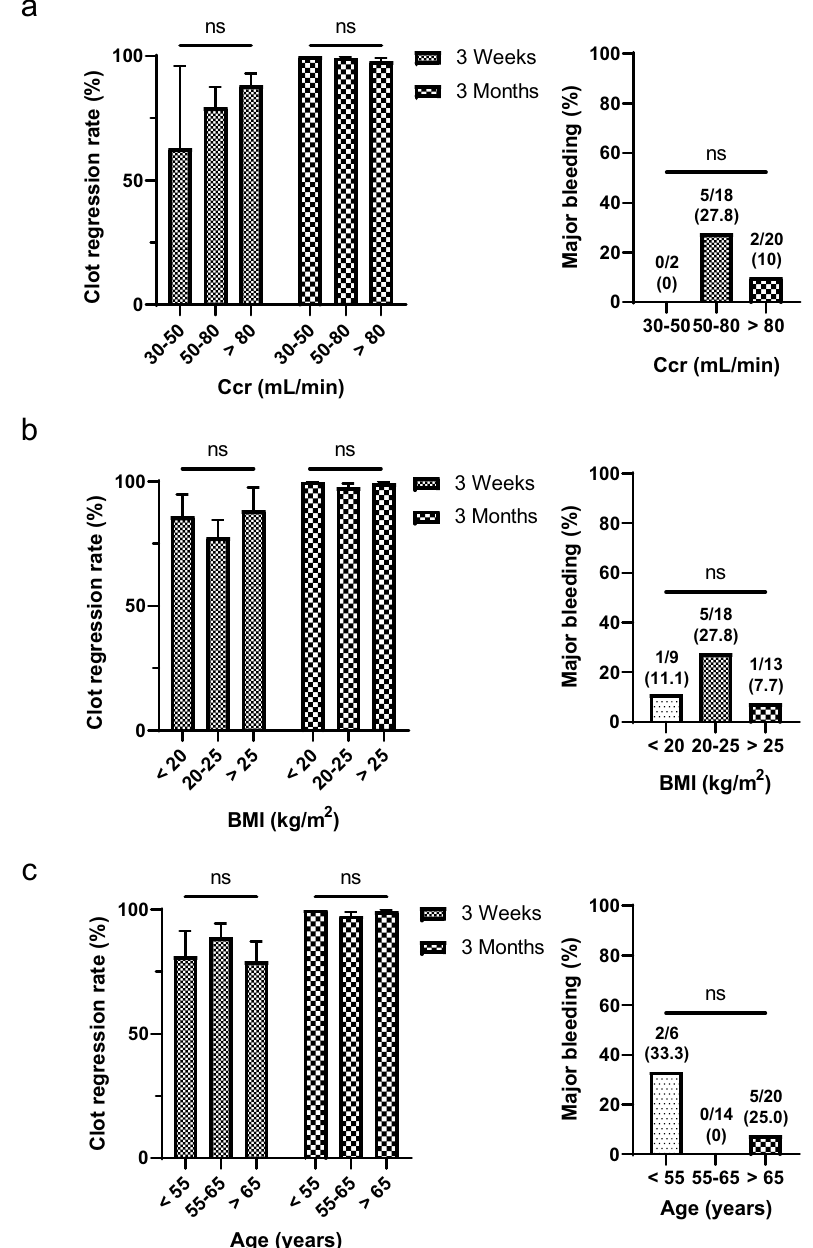
Figure 5. Subgroup analysis for the clot regression effect and safety of rivaroxaban in CAT patients. ( a ) Clot- regression rate and major bleeding based on creatine clearance. ( b ) Clot-regression rate and major bleeding based on body mass index. ( c ) Clot-regression rate and major bleeding based on age. Data are expressed as mean ± standard error or percentage. BMI, body mass index; Ccr, creatine clearance; ns, not